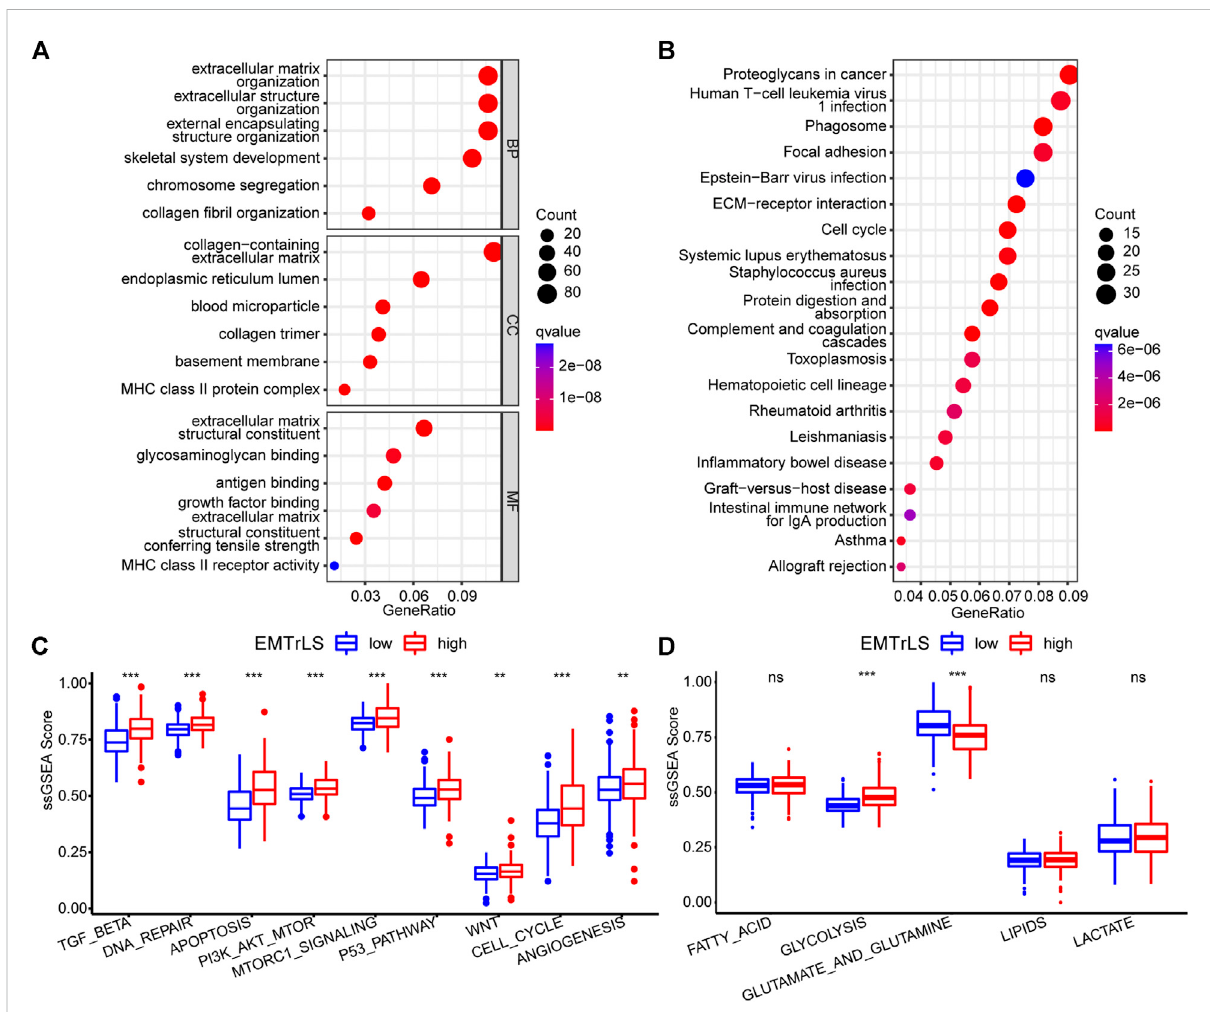
FIGURE 6 (A,B) Functional enrichment analysis of 912 upregulated genes in the EMTrLS-high subgroup was performed using GO analysis of BP, CC, MF, andKEGG (C,D) Analysisof9tumor-associated classicalpathwaysand fi